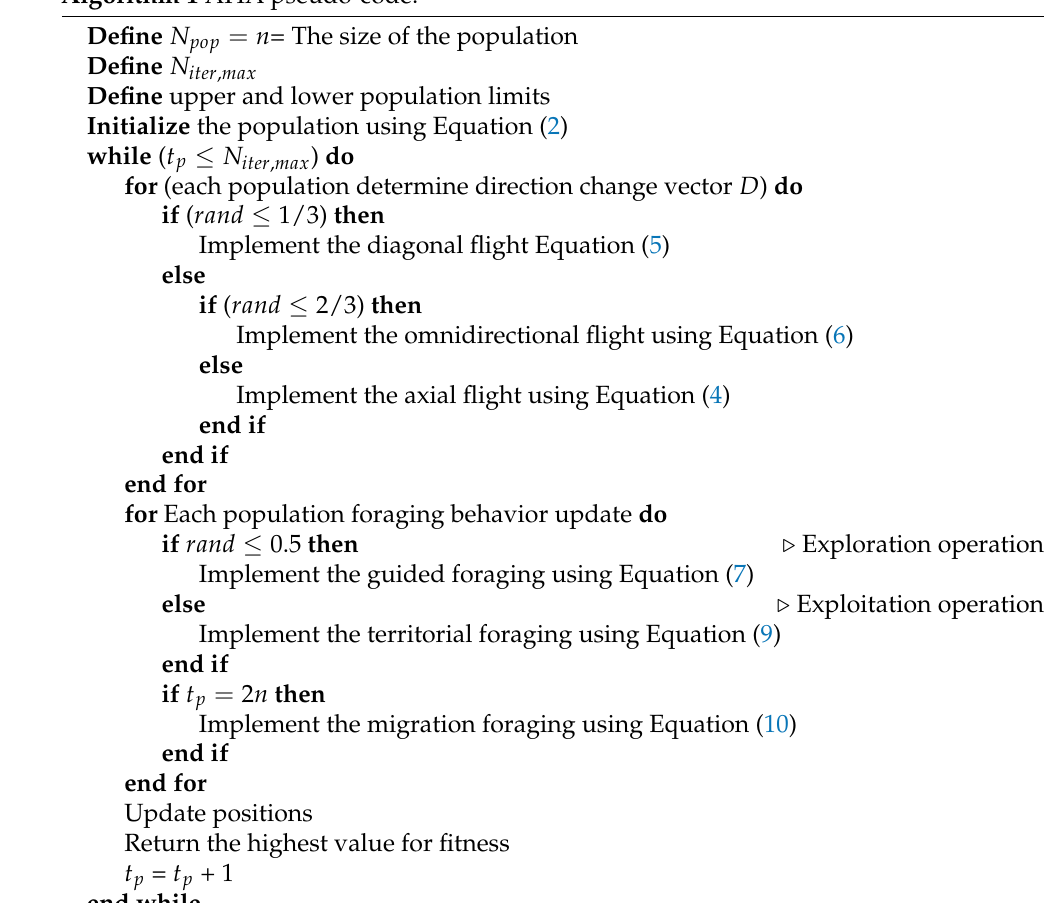
Algorithm 1 AHA